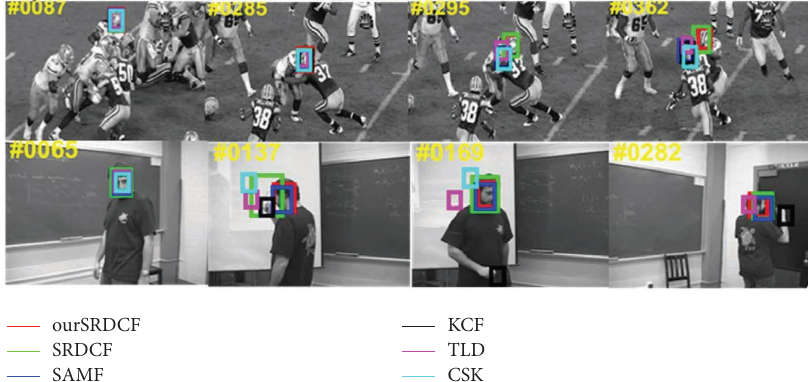
Figure 9: Comparison of tracking results of six algorithms in “football” and “freeman” video sequences.